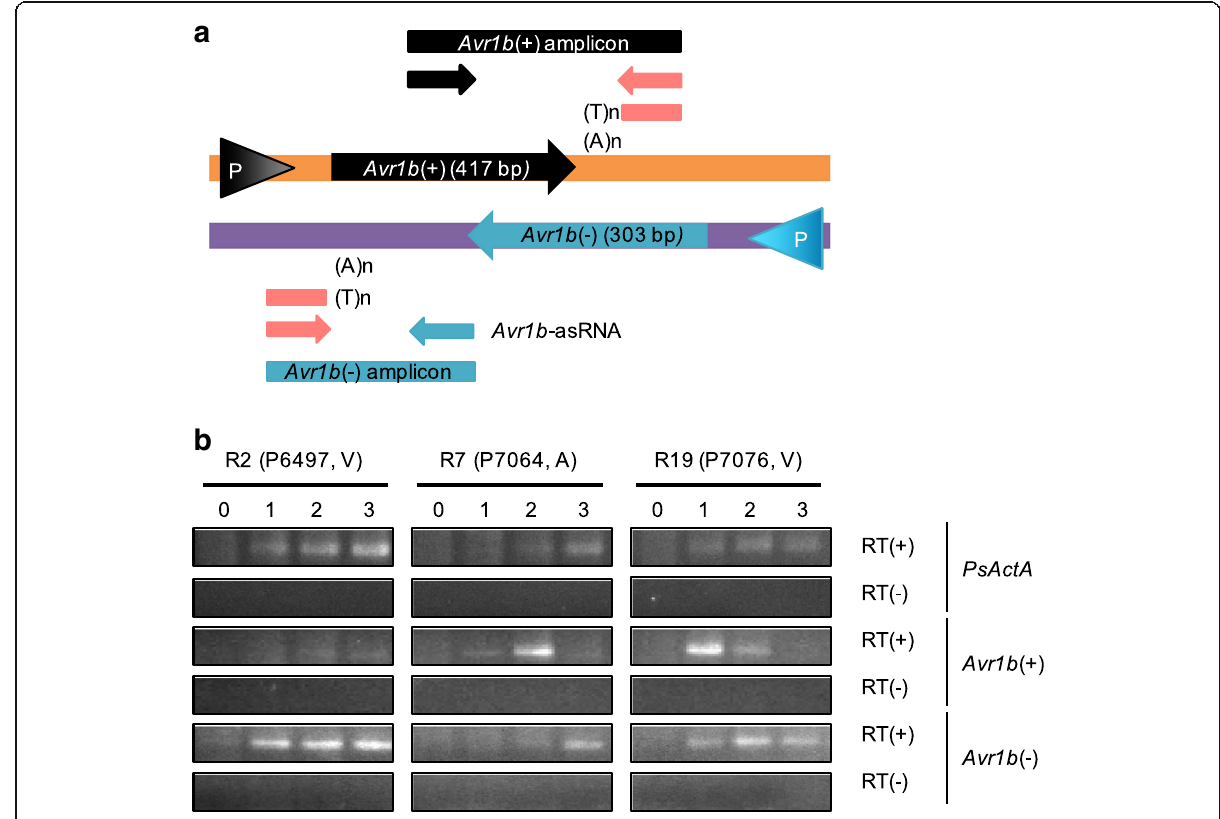
Fig. 4 Bidirectional transcription of P. sojae Avr1b locus. a The model and method for detection of the bidirectional transcription of the Avr1b locus. Avr1b (+) and Avr1b ( − ) are organized in a tail-to-tail manner with more than 200bp overlapping sequence. Oligo dT with an adaptor sequence (in red) was used for the first strand cDNA synthesis, and PCR was performed by using the combinations of Avr1b -asRNA sense (small blue arrow) primer, Avr1b -asRNA antisense (small black arrow) and the adaptor (small red arrow) primers. P, the promoter. b RT-PCR validation of the bidirectional transcription. G. max cultivar Williams ( rps1b ) infected with different strains of P. sojae were sampled at 0, 1, 2, and 3 dpi, respectively. Equal amount of total RNAs were used for each RT-PCR assays. RT(+) indicates the amplicon of RT-PCR, and RT( − ) indicates the control reactions without cDNA synthesis (no reverse transcriptase applied). PsActA was amplified for 30cycles and was used as a reference gene, while Avr1b (+) and Avr1b ( − ) were amplified for